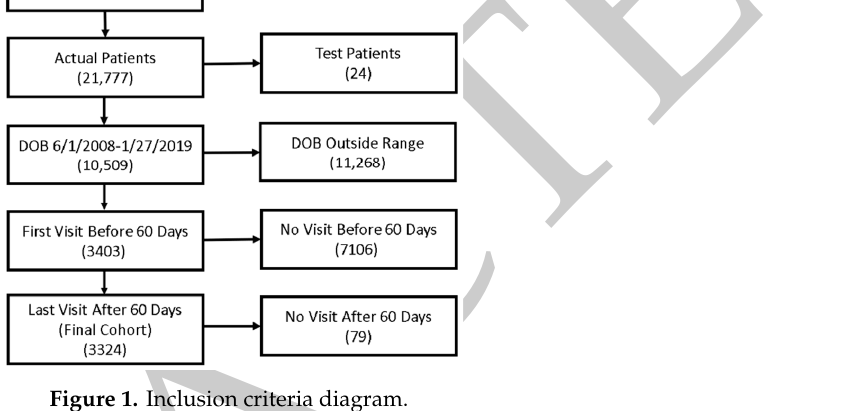
Figure 1. Inclusion criteria diagram.